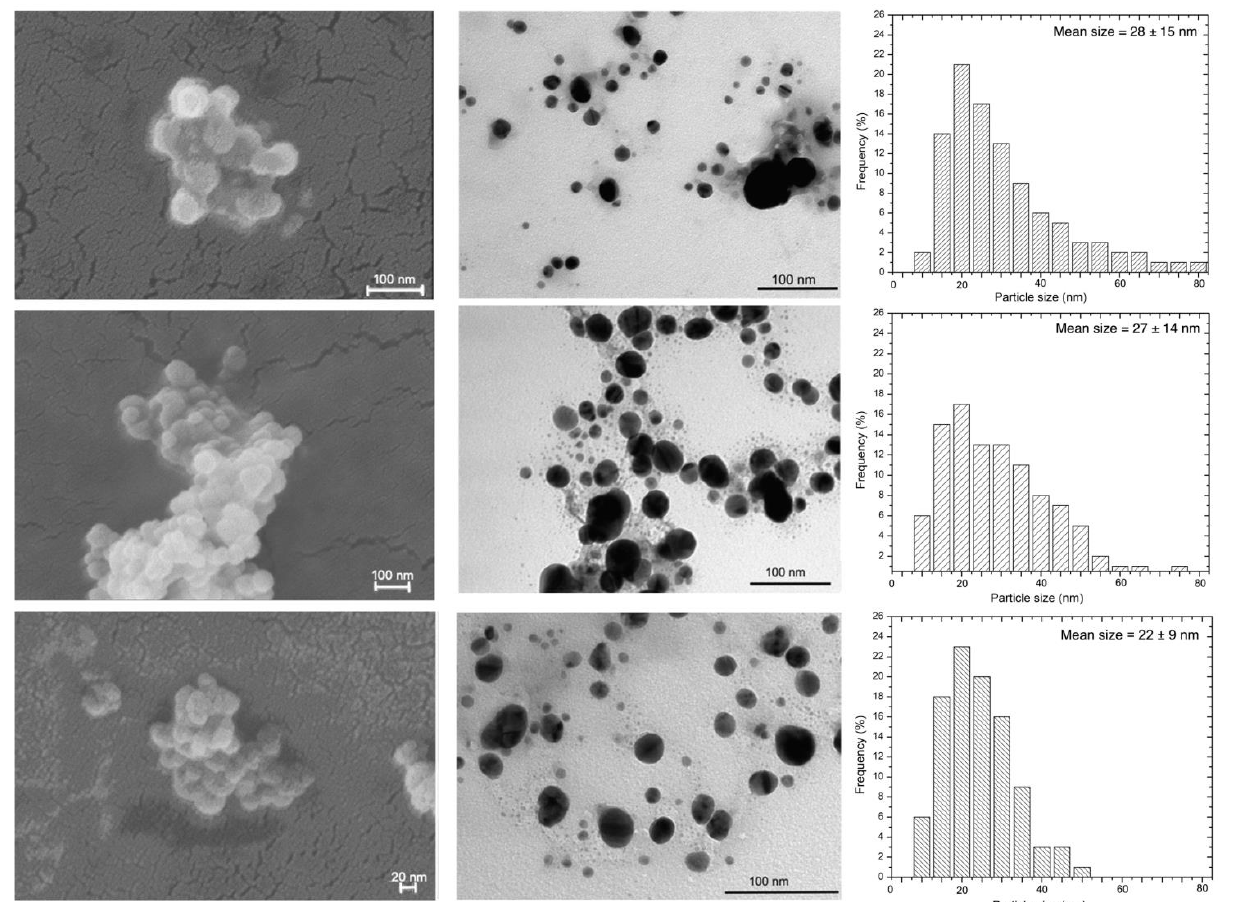
Figure 4. SEM micrographs ( left column), TEM micrographs ( central column) and AgNPs size distribution determined by TEM images ( right column) for the samples A, G and H (from top to bottom).